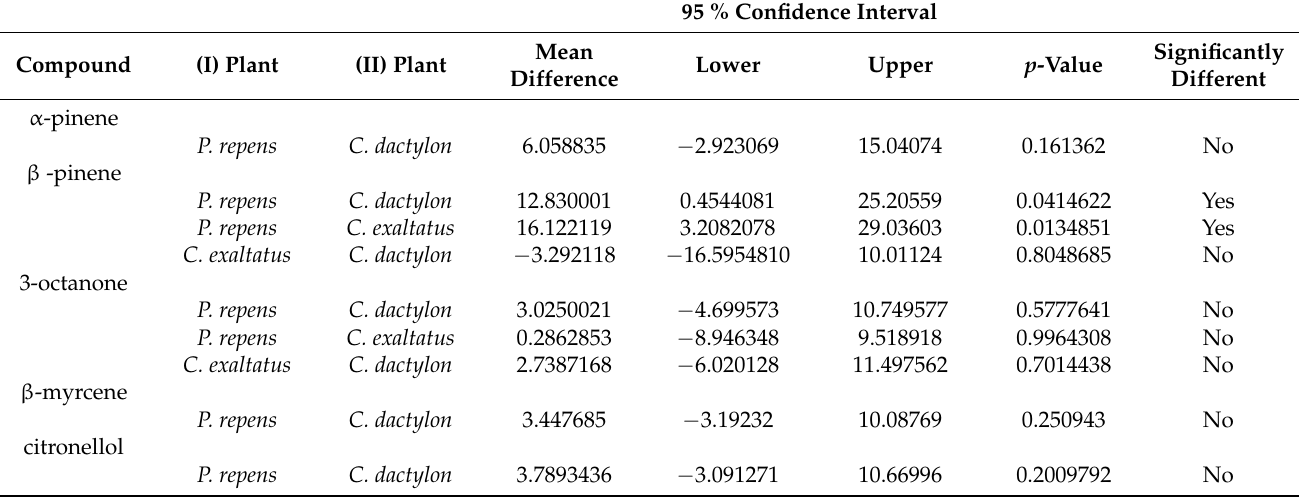
Table 2. Post-hoc Tukey analysis of five compounds found in the headspace of at least two of the three graminoid plants. 95 % Confidence